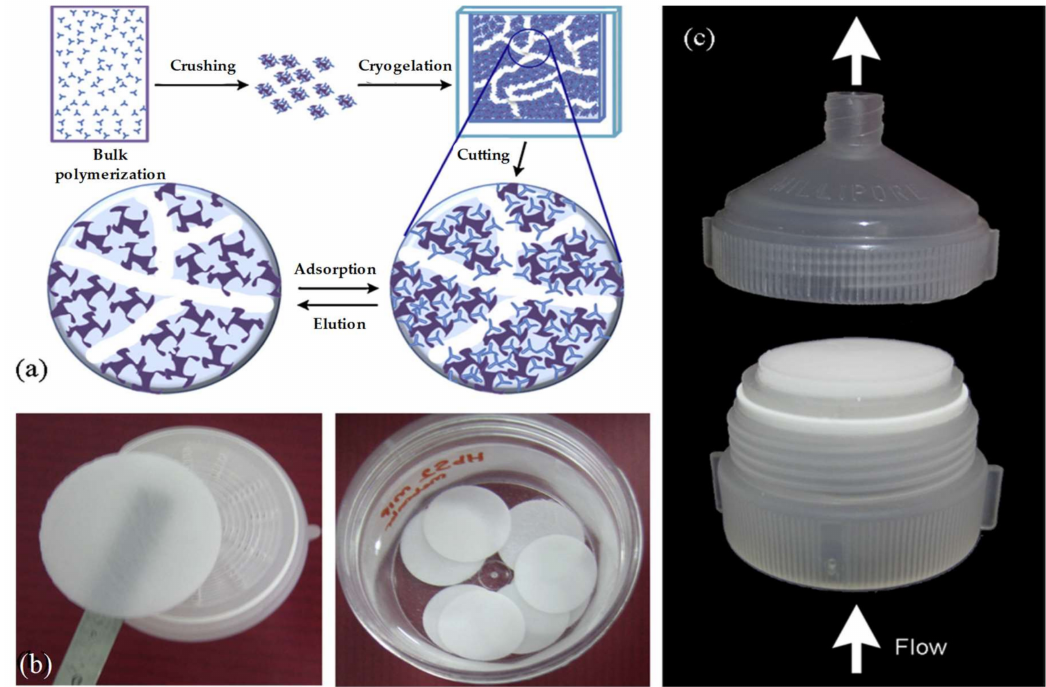
Figure 5. Scheme of the steps of composite cryogel formation ( a ), images of circular composite cryogels ( b ) and continuous operation setup for adsorption experiments ( c ). Republished with permission from [49]. Copyright 2012